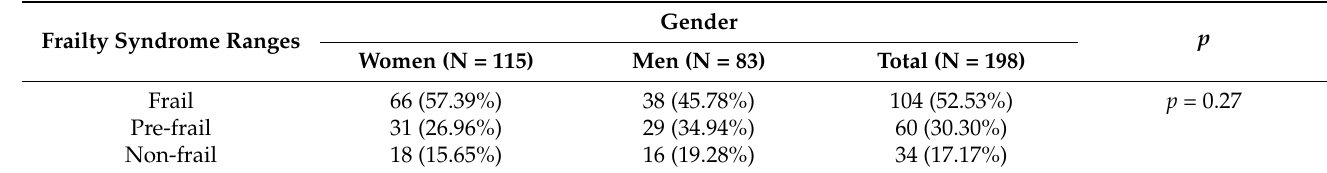
Table 3. The proportion of frail, pre-frail and non-frail residents in a sample group.